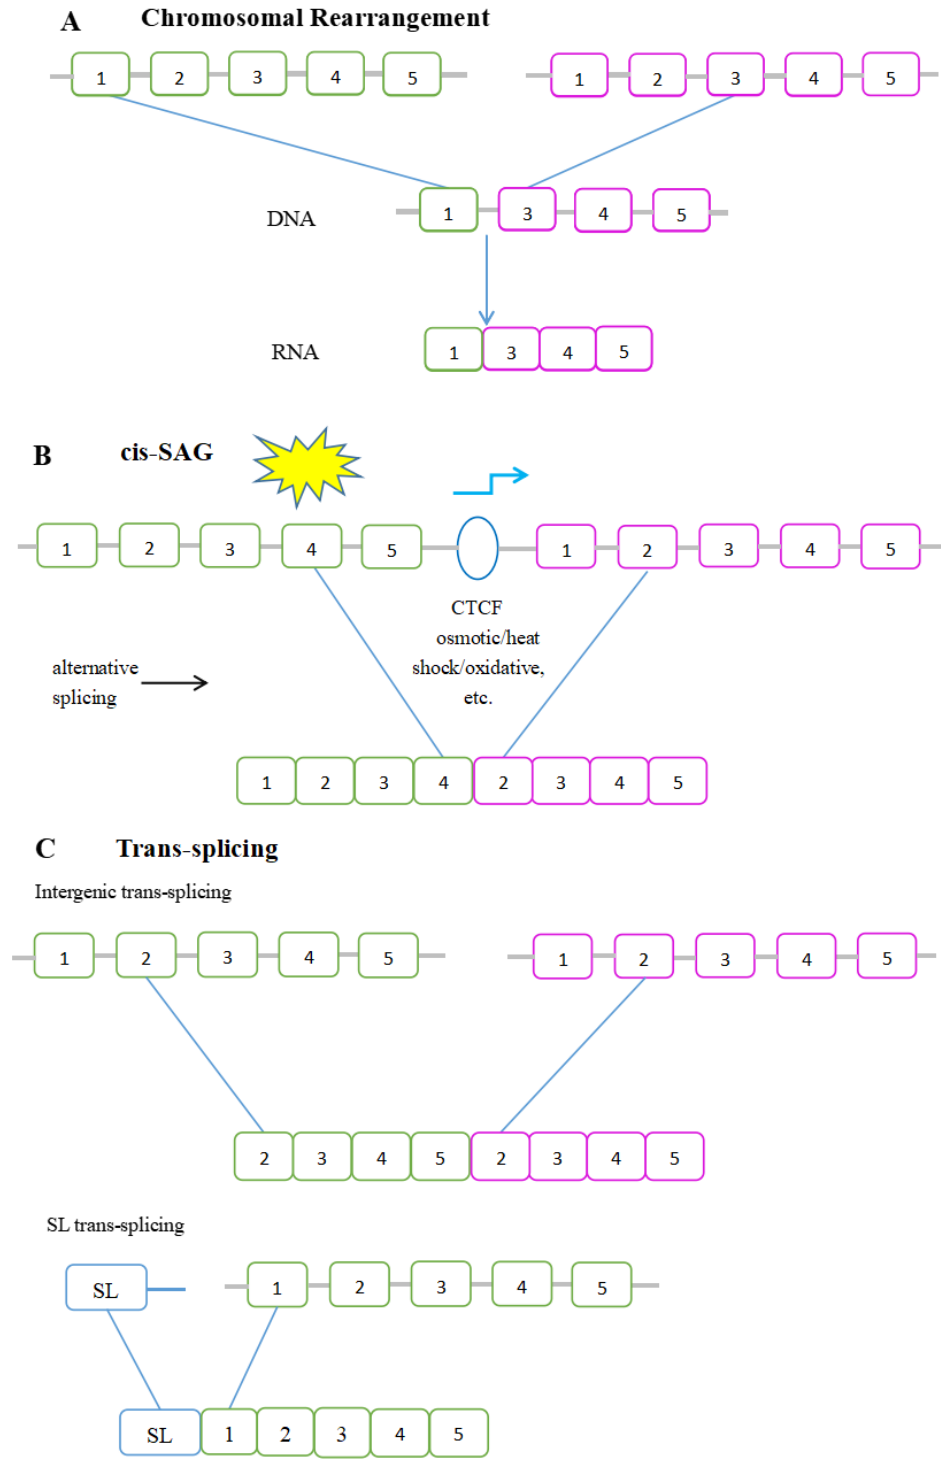
Figure 1. The depiction of chimeric RNAs generated by ( A ) gene fusion; ( B ) cis-SAGe; ( C ) trans- splicing. Bars represent exons and lines represent introns and intergenic regions. Many potential cis-SAGe chimeric RNAs have been identified by a systematic in silico analysis and paired-end RNA-seq [5]. Qin et al. analyzed both prostate cancer and non- cancerous samples and observed that 30% of all 300 chimeric RNA events were cis-SAGe chimeras [21]. In another study, 76% of the candidates were classified as cis-SAGe chimeric RNAs [24]. cis-SAGe were also found in healthy tissue samples, suggesting that there is